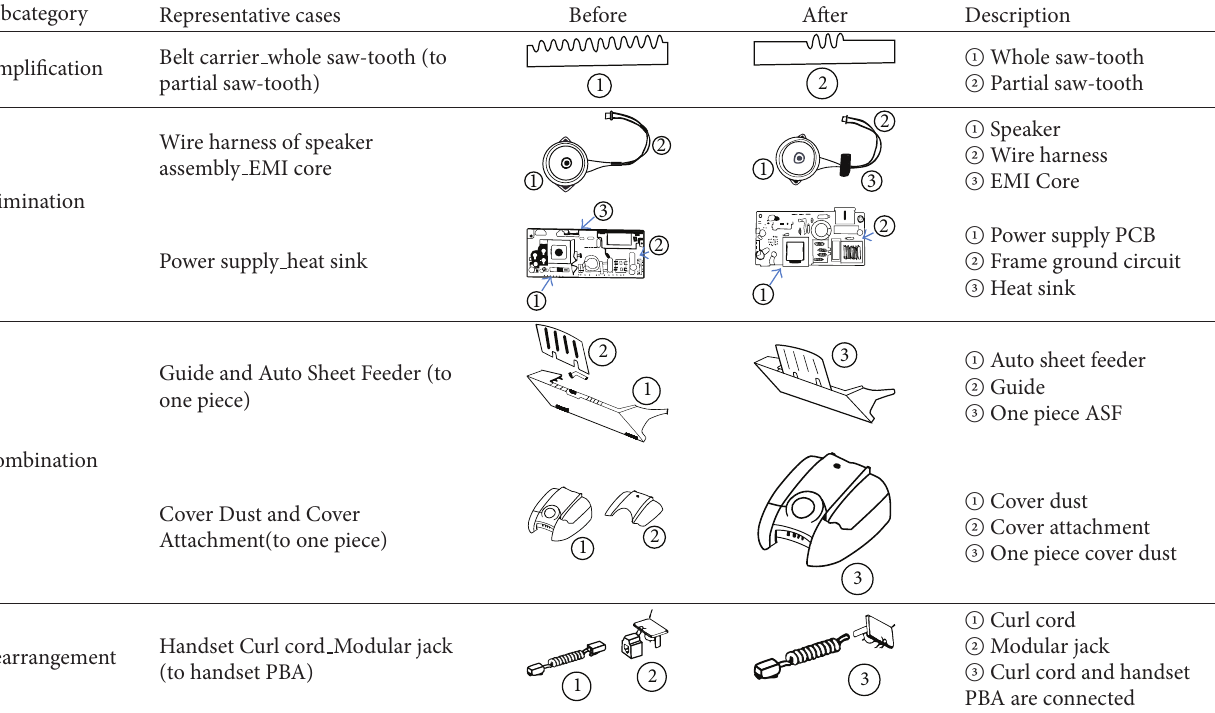
Table 3: Graphical illustration of form/structure